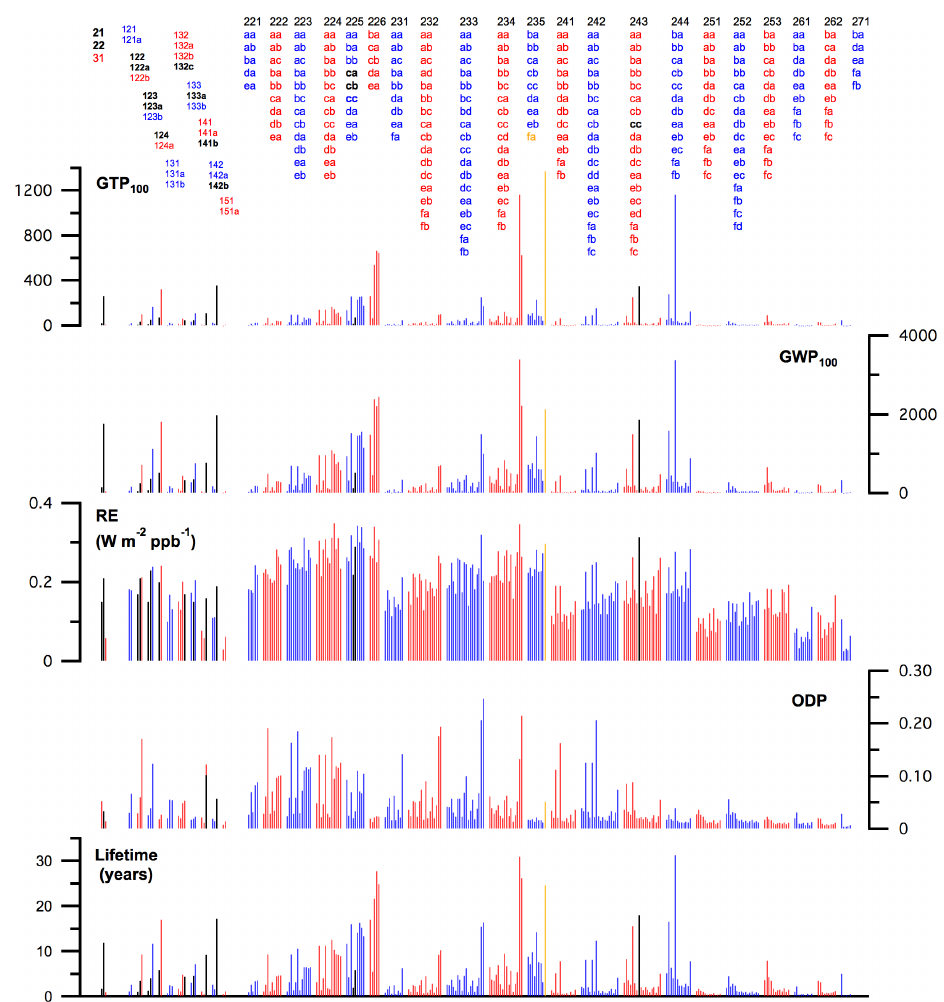
Figure 7. Summary of the results obtained in this study for C 1 –C 3 HCFCs (red and blue) and the values for which experimentally derived metrics are available (black). The lifetime, GWP, and GTP values for HCFC-235fa (CClF 2 CH 2 CF 3 ) (gold) have been multiplied by 0.4 to improve the overall graphical